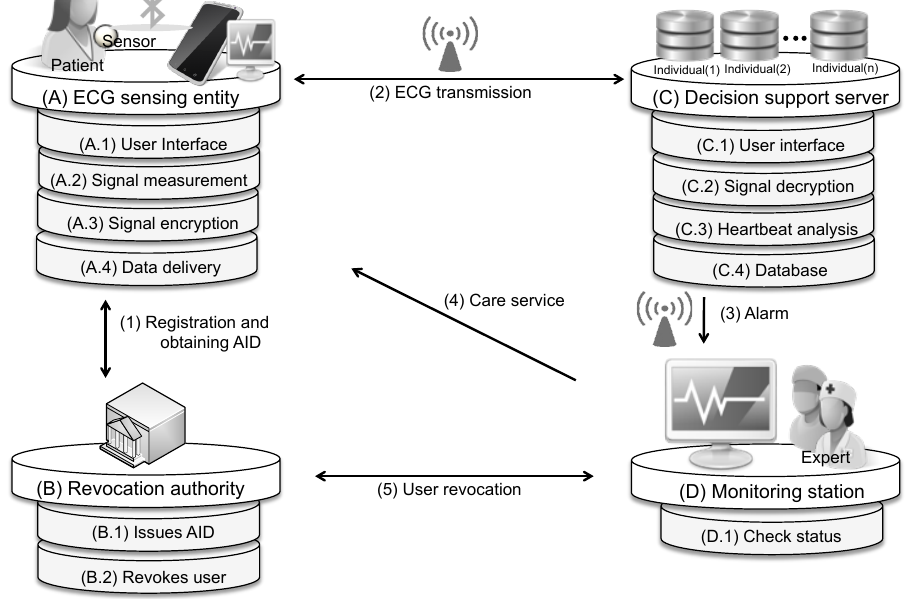
Figure 2. Overview of the proposed system architecture. AID, anonymous ID.